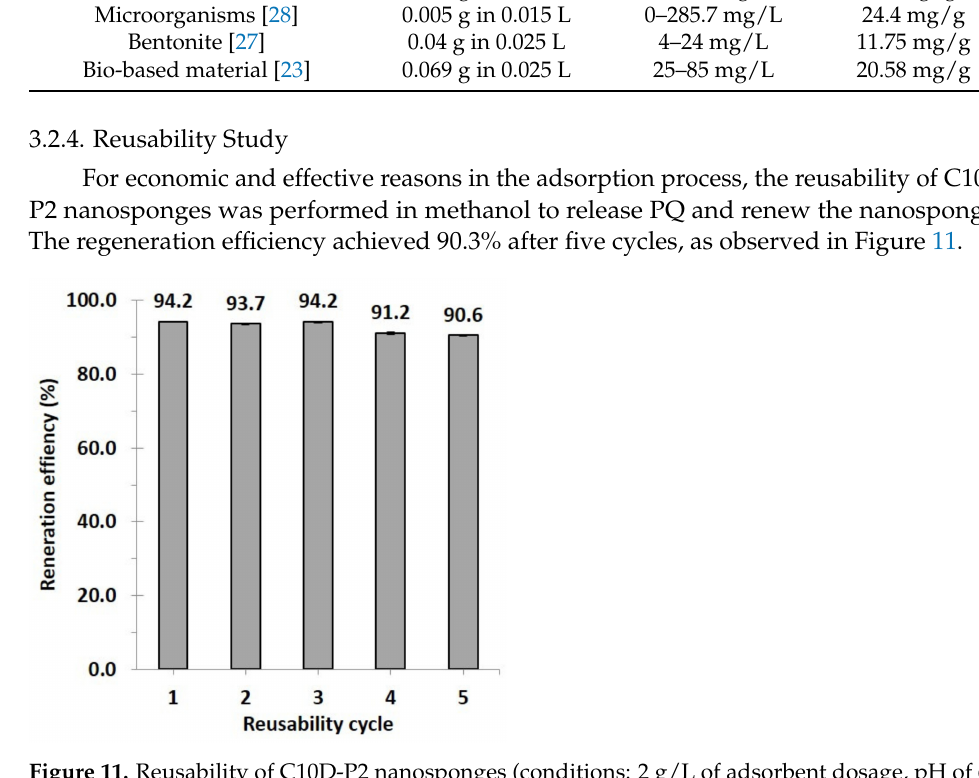
Figure 11. Reusability of C10D-P2 nanosponges (conditions: 2 g/L of adsorbent dosage, pH of 6.5, and temperature at 303